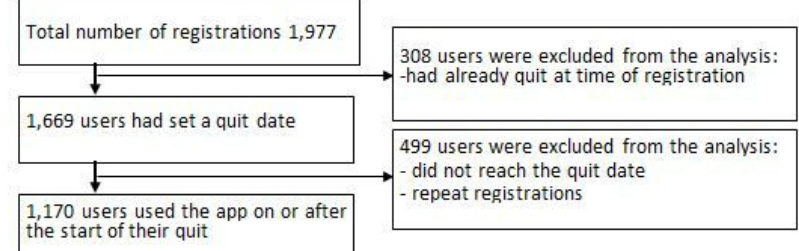
Figure 2. Participant